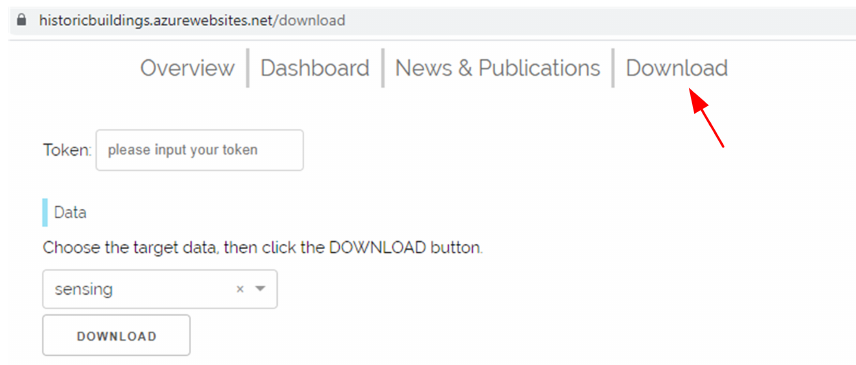
Figure 11. The download page supports sharing collected raw data between partners.